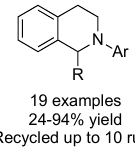
perform the sequential Friedländer reaction followed by a Pd(PPh 3 ) 4 /Xantphos-catalyzed α-alkylation of the quinolinyl methyl ketone with benzyl alcohol through a hydrogen mixture DMU:tartaric acid (7:3) in the presence of an iridium catalyst to access (E)-4-ben- zylidenylacridines and (E)-2-styrilquinoline-3-carboxamides [87]. To further expand this strategy, the same authors also synthesized a series of spiro[indoline-3,3′-pyrrolizin]-2′- yl)-4-phenylquinoline-3-carboxylates, in this case performing the C(sp 3 )-H functionaliza- tion using Cu(OAc) 2 and TEMPO as a catalytic system (Figure 30, Table 4, entry 3) [88].